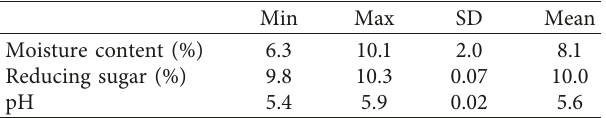
Table 2: Characters of traditional Kolompeh